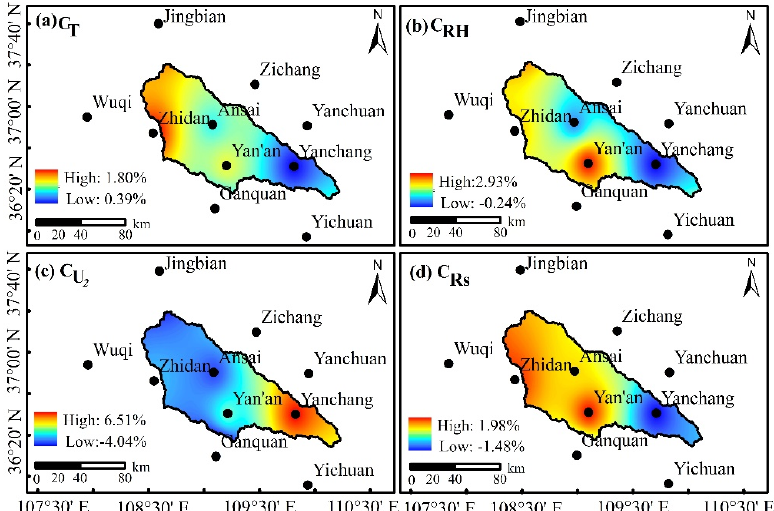
Figure 5. Spatial distribution of contribution rate of each meteorological factor: ( a ) air temperature, ( b ) humidity, ( c ) wind speed at 2m height, ( d ) solar radiation.